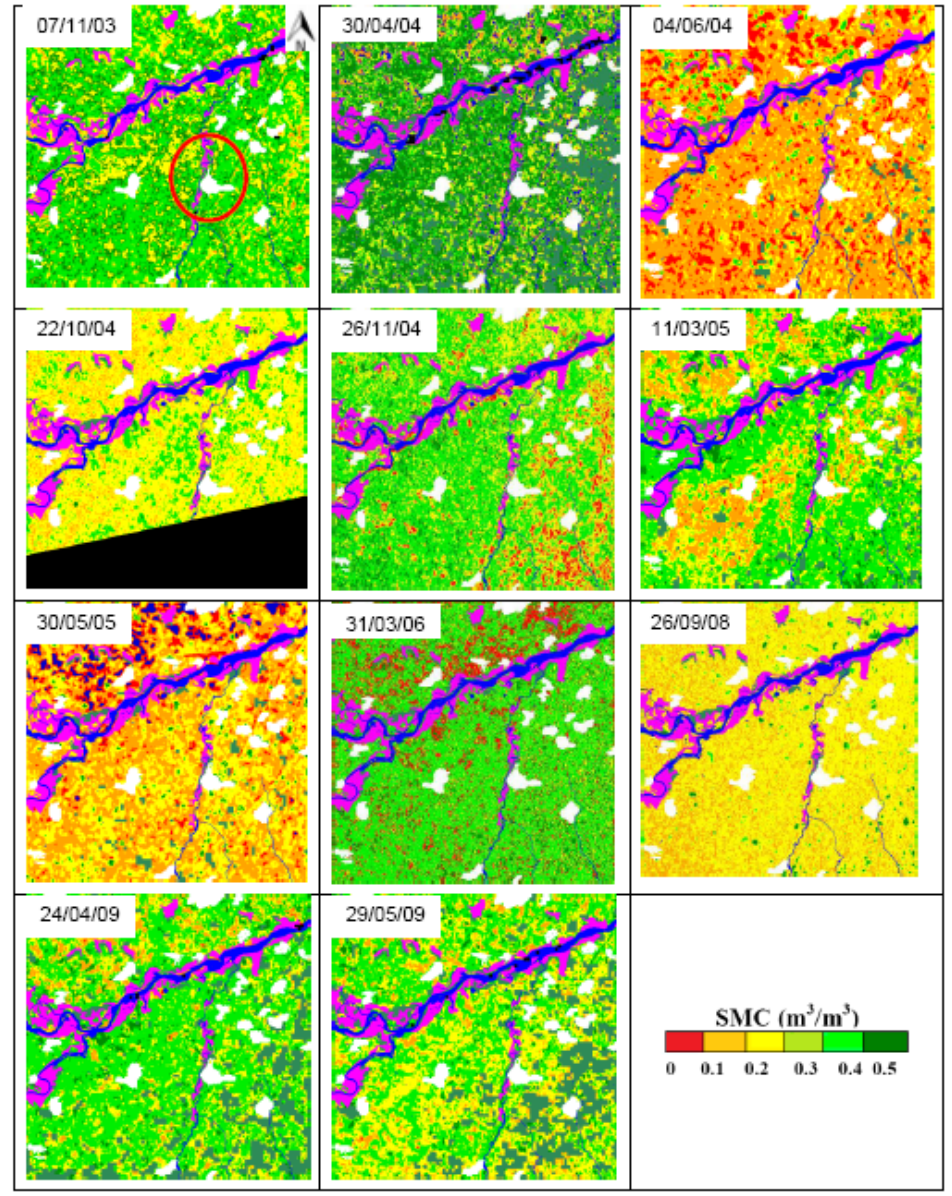
Figure 2. Soil moisture content (SMC) maps in (m 3 /m 3 ) obtained through the Artificial Neural Network (ANN) algorithm by using ENVISAT/ASAR images collected on the Scrivia area (central coordinates: 45°N–8.80°E). Masked areas are: white = urban, magenta = forests, dark green = dense vegetation, blue = open water. The dimensions of the images are 20 × 20 km. In the red circle, the area where ground measurements were collected is